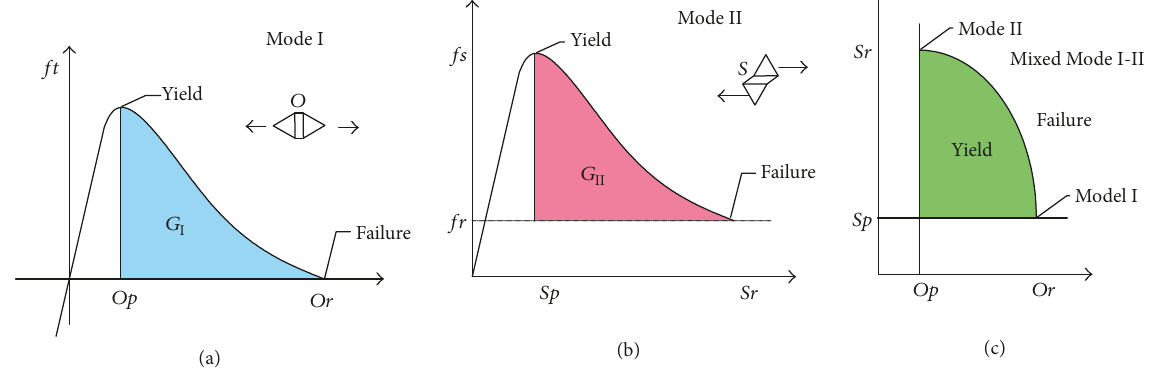
Figure 5: Constitutive behavior of the joint element. (a) Mode I. (b) Mode II. (c) Mixed Mode I-II.